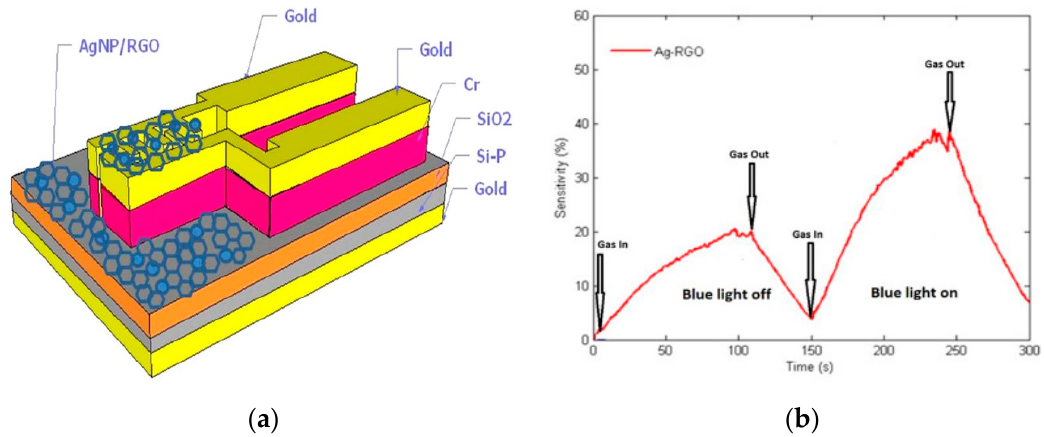
Figure 9. ( a ) Scheme of sensing layers of AgNPs/reduced graphene oxide (rGO) sensor; ( b ) AgNPs/rGO response vs. time at 20 ppm NH 3 with and without irradiation by visible light (10 mW/cm − 2 ) [173]. With the permission of IOP.